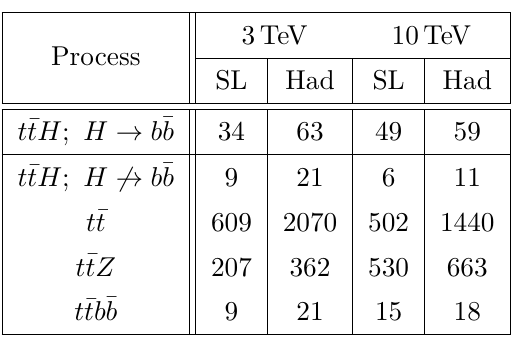
Table 8 . A summary of the signal and background events for t ¯ tH production in the H → b channel after all analysis cuts. All of these processes include both s -channel production and VBF production